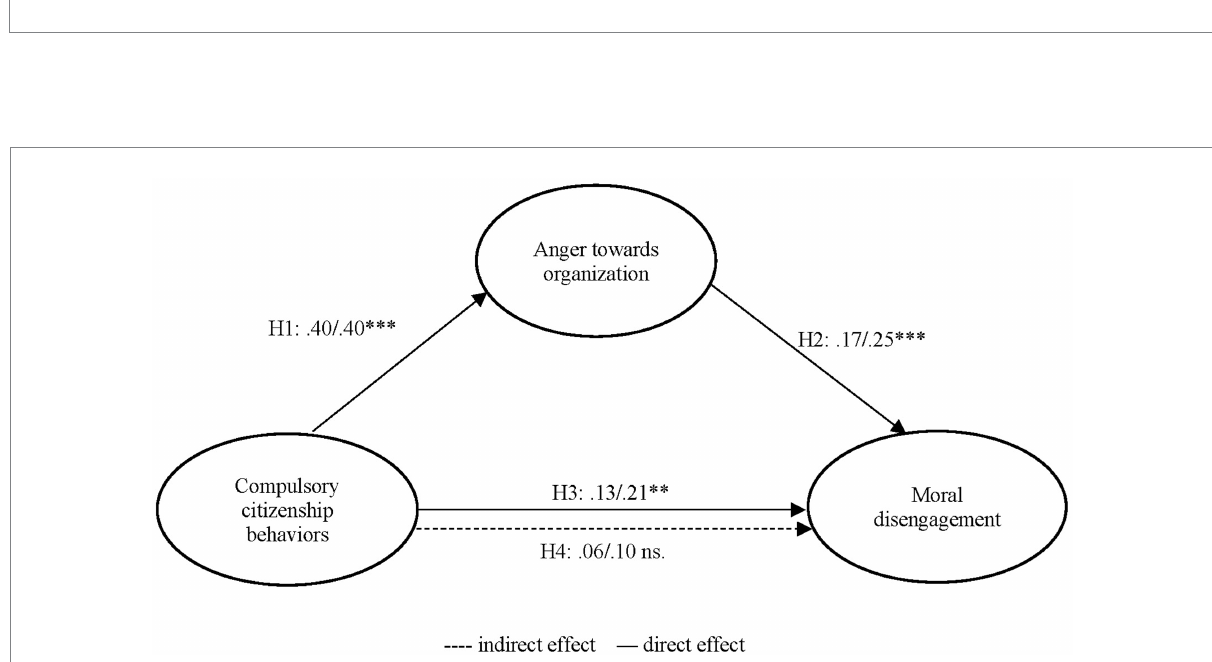
FIGURE 3 Unstandardized/standardized estimates of covariance-based structural equation model (CB-SEM). ns. indicates not significant ( p > 0.05), ** represents p < 0.01, and *** represents p <